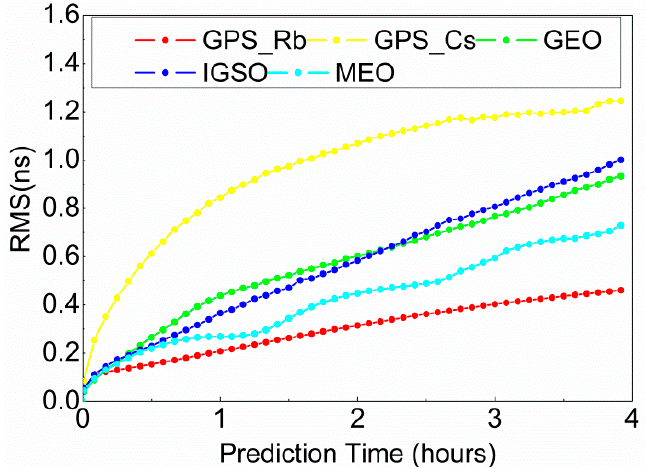
Figure 1. Root mean square (RMS) of the prediction errors of different satellite clock types under different time latencies.